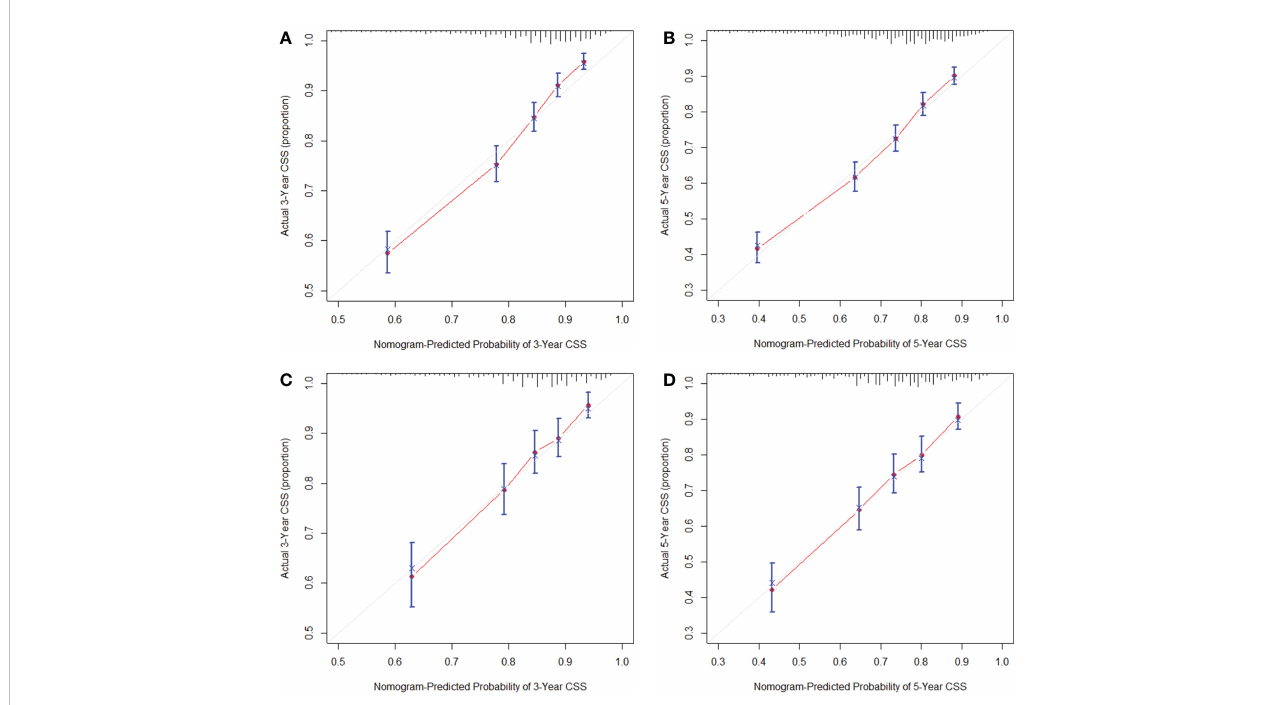
FIGURE 3 Calibration plots of the nomogram for 3-year (A) and 5-year CSS (B) in the development cohort; calibration plots of the nomogram for 3-year (C) and 5- year CSS (D) in the validation